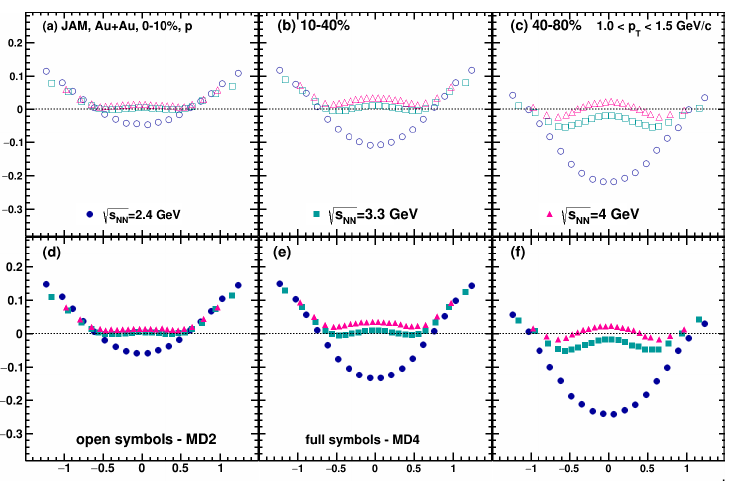
Figure 17. Scaled rapidity ( y (cid:48) = y cm / y beam ) dependence of v 2 of protons in the central 0–10% ( a , d ), midcentral 10–40% ( b , e ) and peripheral 40–80% ( c , f ) Au + Au collisions at The full symbols correspond to the JAM model with soft momentum dependent mean-field MD4 ( K 0 = 220 MeV) EOS and open symbols to the hard MD2 ( K 0 = 380 MeV) EOS.